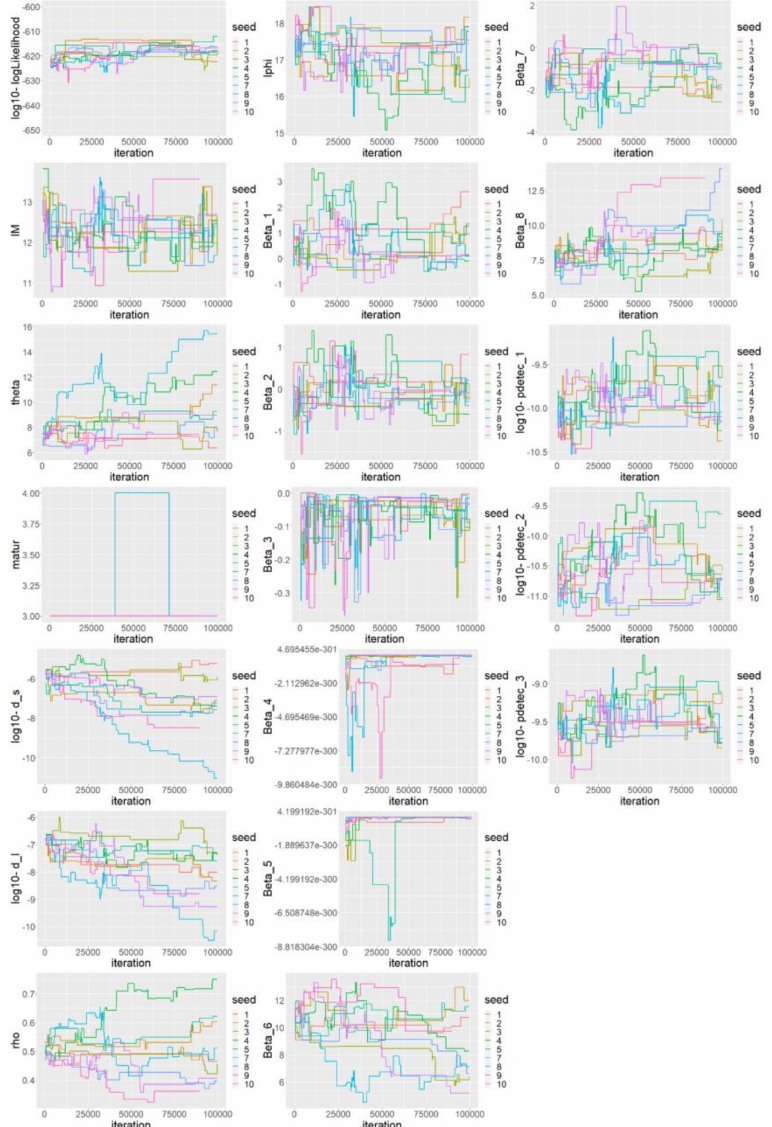
Figure A3. Trace plots of the 18 main model parameters for the 100,000 iterations of the third and last MCMC session and for 10 independent